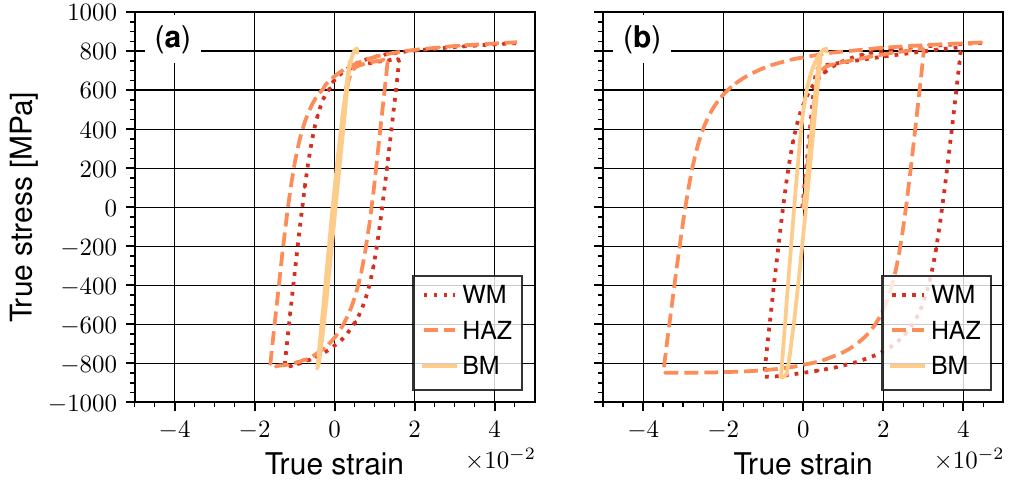
Figure 7. True stress–true strain hysteresis loops recorded during the V–C model parameter estima- tion experiments: ( a ) Specimen 2, ε a = 1.0%, and ( b ) specimen 1, ε a = 2.0%. The strain was only recorded up to ε =